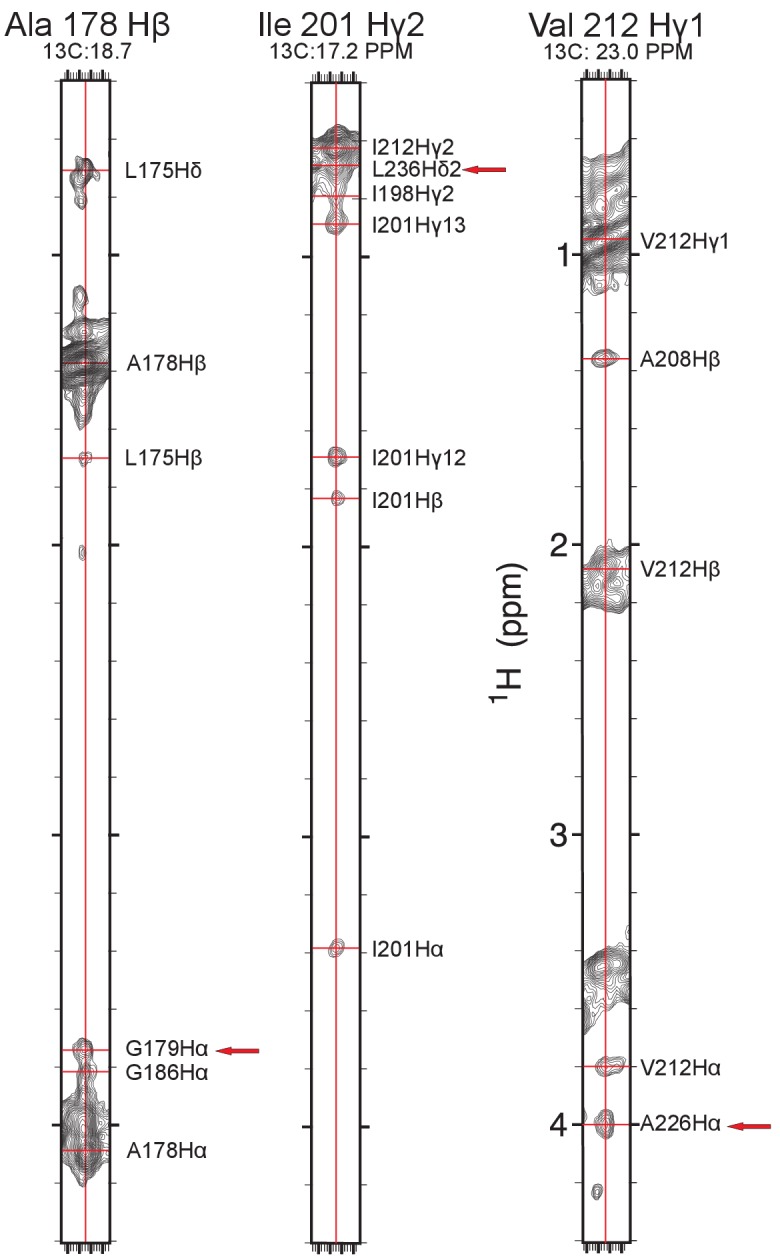
Examples of NOE measurements.Example strip plots showing long-range methyl-methyl and methyl-backbone Hα proton NOEs (red arrows) taken from the methyl-optimized 3D 13C-edited NOESY recorded on a 13C,15N-labeled sample in deuterated LMPG. The chemical shift assignments illustrated in this figure have been deposited in BioMagResBank (BMRB ID 30517).